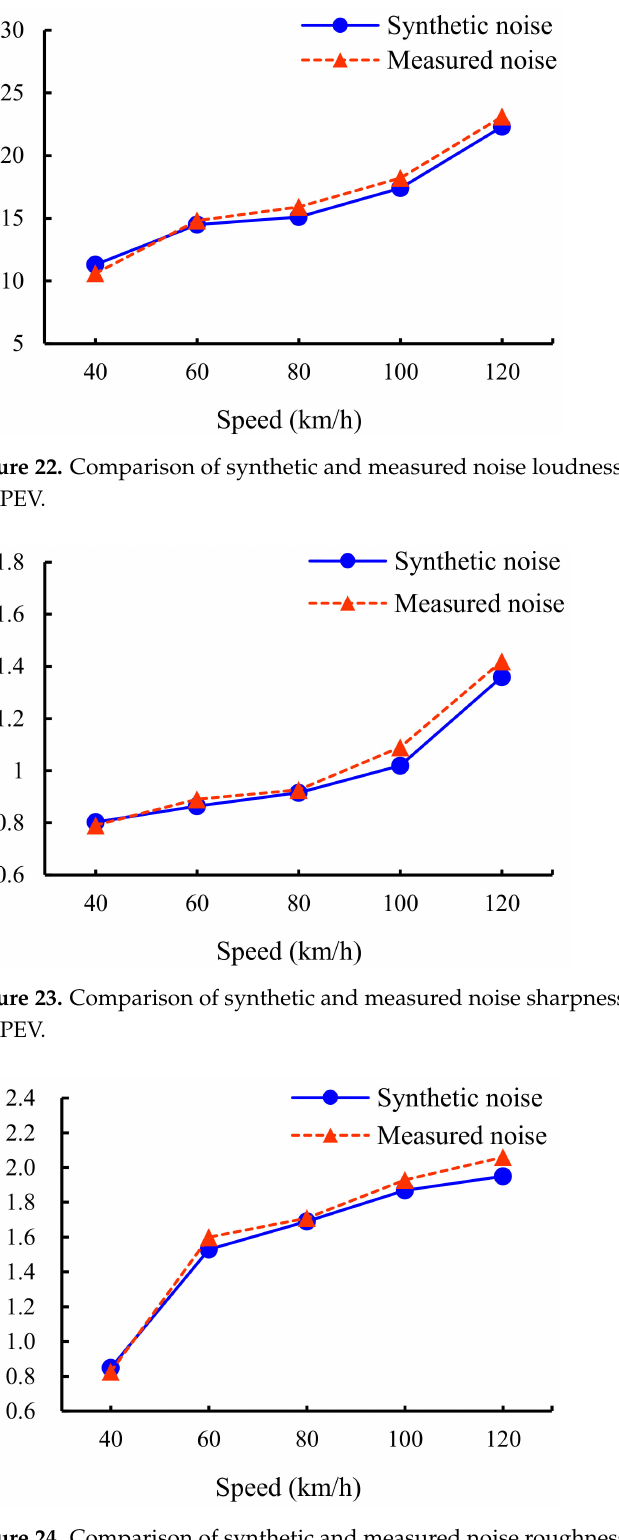
Figure 24. Comparison of synthetic and measured noise roughness at different operating speeds of the